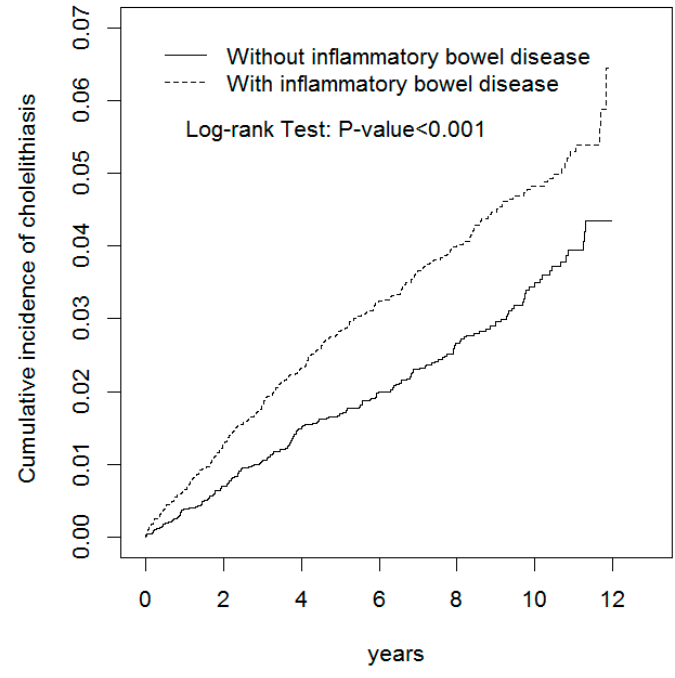
Figure 1. Cumulative incidences of cholelithiasis among patients with (dashed line) and without (solid line) inflammatory bowel disease.